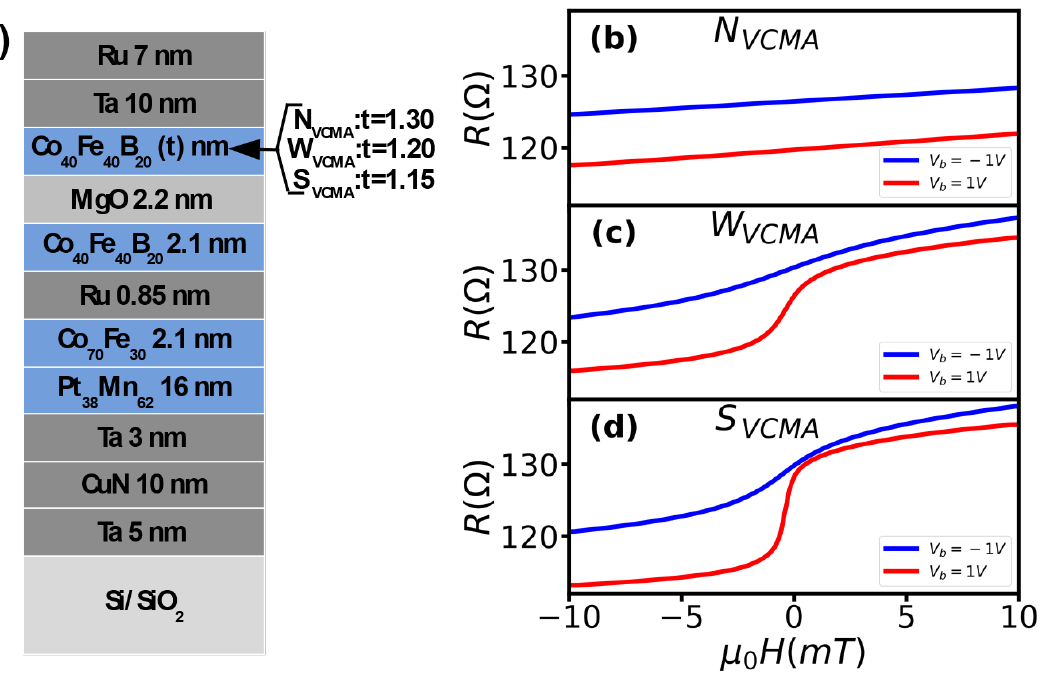
Figure 1. Material structure of the sensors ( a ), transfer curves of sensors without ( b ) and with VCMA modification ( c , d ) for positive and negative bias voltage. modification ( c , d ) for positive and negative bias